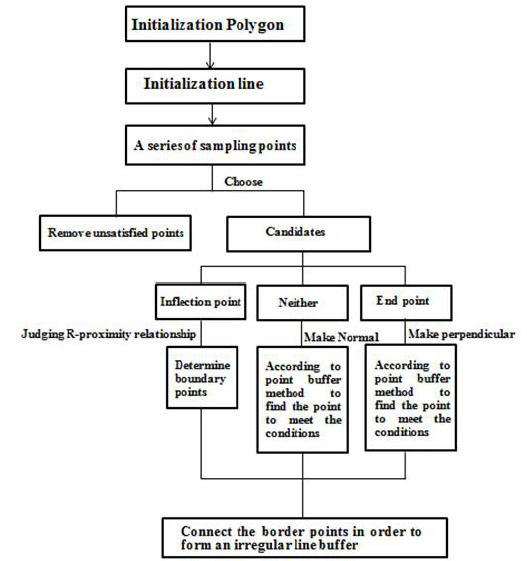
Figure 4. Irregular polygon buffer implementation